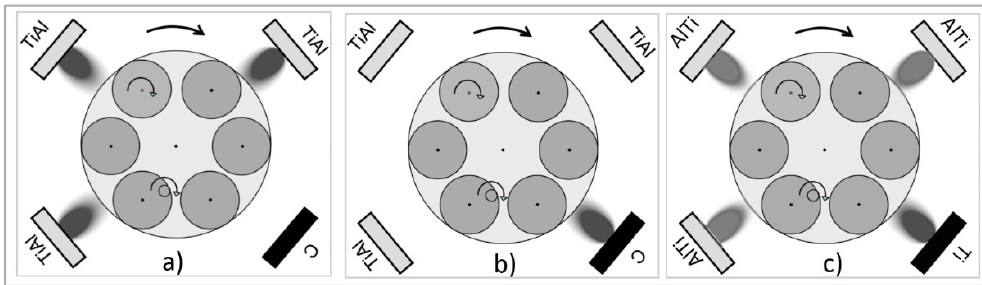
Figure 1. Configurations of targets for the deposition of a TiAlN/a-C:N coating bottom TiAlN layer ( a ), TiAlN/a-C:N coating top a-C:N layer ( b ) and AlTiN/TiN coating ( c ) [32]. The blades were either in horizontal position (with 3-fold rotation, designation 3L) or in vertical position (with 2-fold rotation, designation 2P). In the first case, the thickness of both kinds of coatings was ca. 2 µm, while in the latter case, it was ca. 5 µm. In the deposition chamber, the substrates were heated to 400 °C for 60 min. Mid-frequency ion etching with pulsed bias on a turntable at a voltage of 650 V and a frequency of 240 kHz was conducted for 45 min in a mixed argon (flow rate 180 sccm) and krypton (flow rate 50 sccm) atmosphere under a pressure of 0.35 Pa.